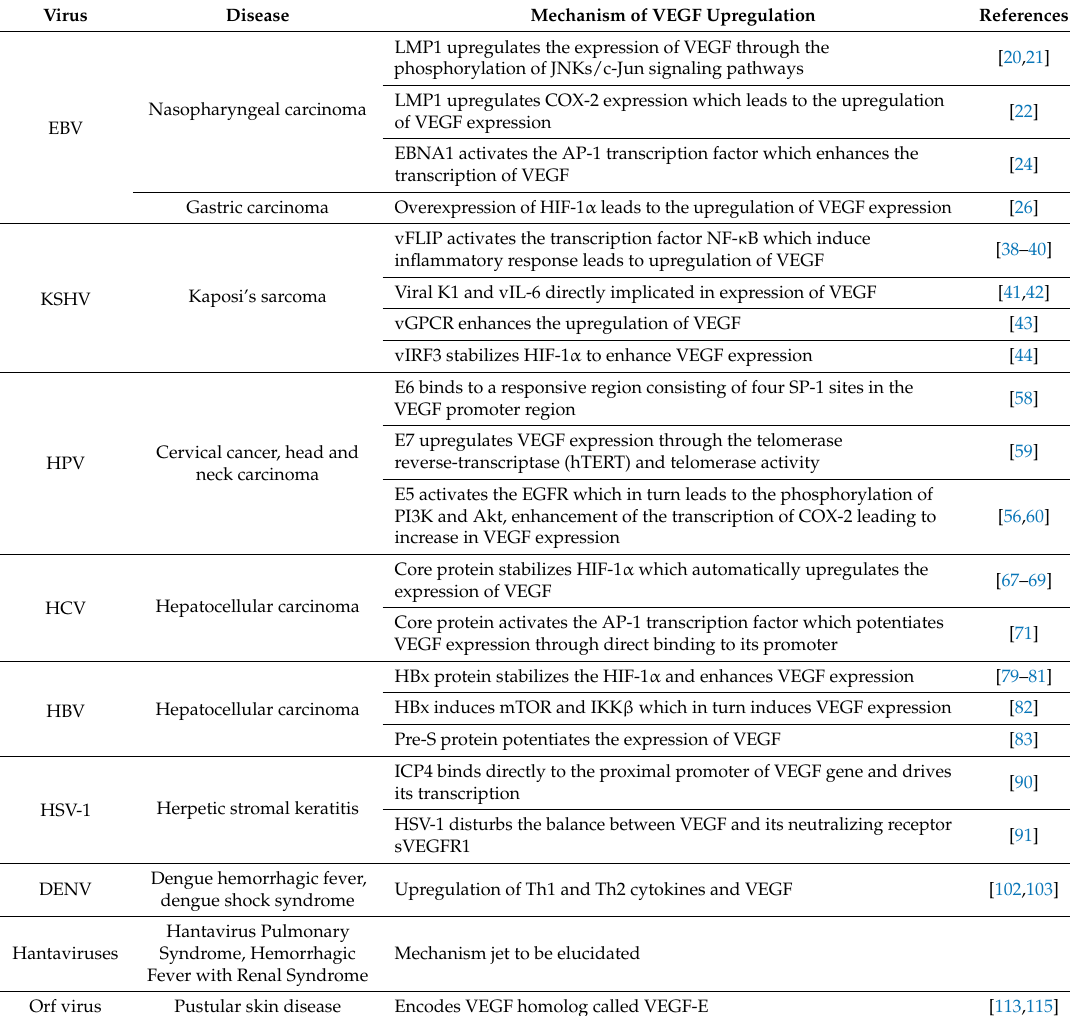
Table 1. Summary of viruses exploiting vascular endothelial growth factor (VEGF) upregulation in human